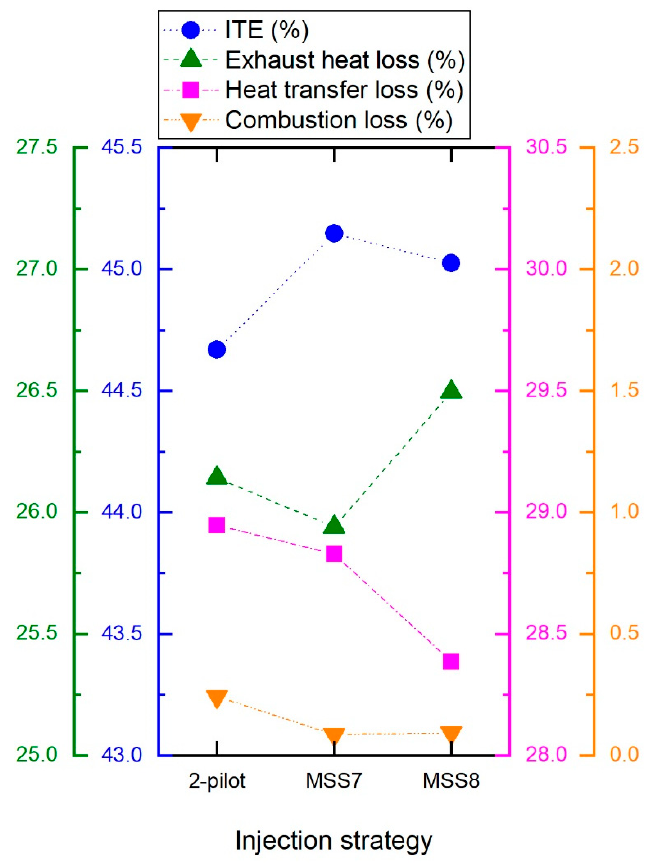
Figure 14. Energy balance analysis of the two-pilot injection strategy and the two MSS injection strategies; ITE: indicated thermal efficiency.